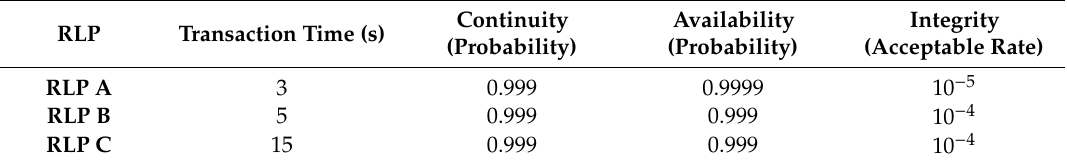
Table 2. Required C2 link performance (RLP) requirements